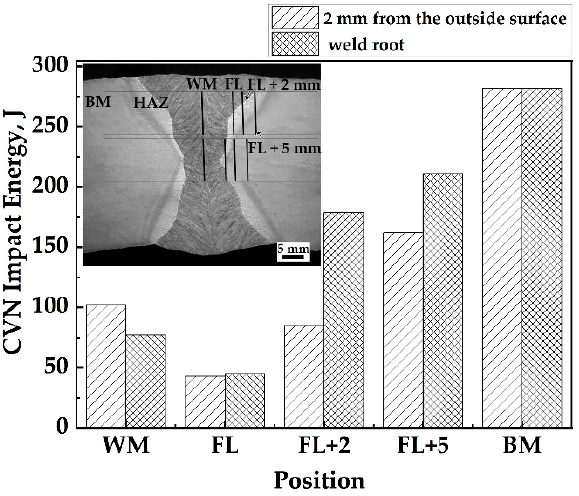
Figure 7. Charpy impact energy of the welded joint notched in different regions.